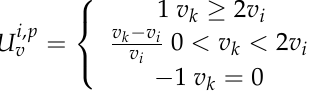
Figure 4. The change trend of 𝑈 (cid:3030)(cid:3042)(cid:3040)(cid:3033)(cid:3042)(cid:3045)(cid:3047) − 𝑡 (cid:3030)(cid:3028) .